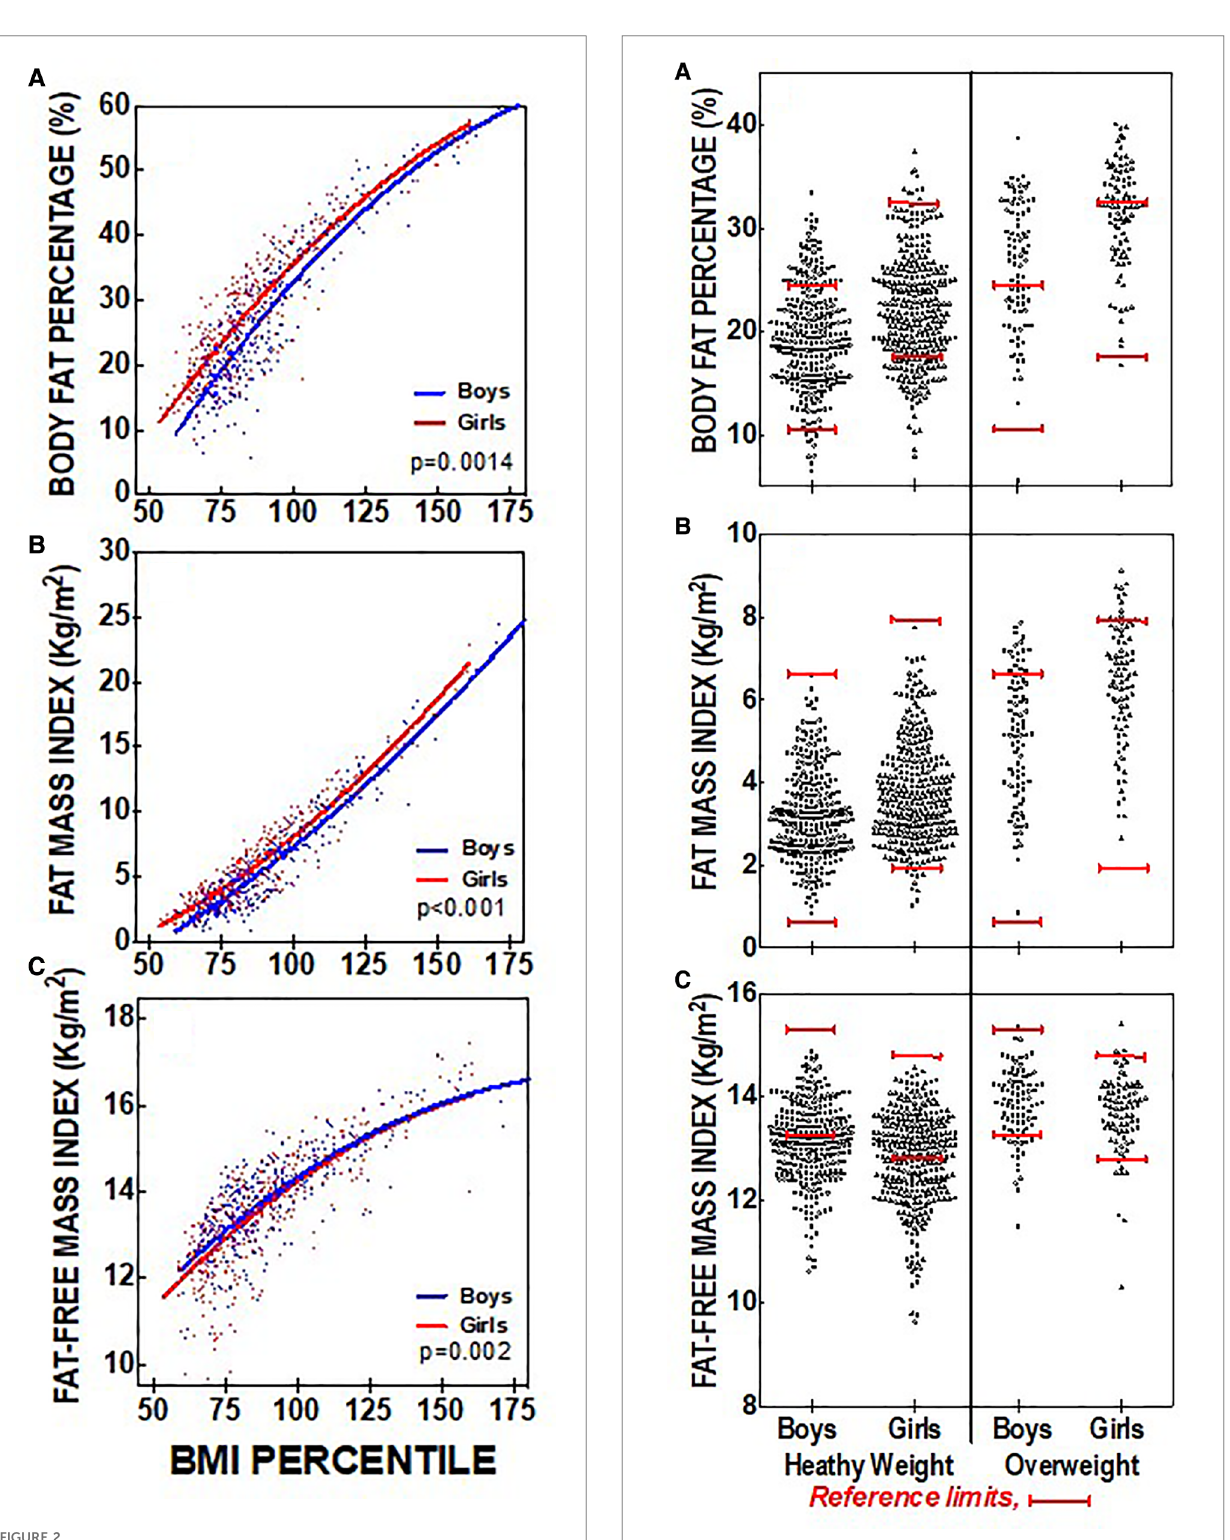
FIGURE 2 Distribution of body composition and indexes measures for the obese BMI%-based weight categories for boys and girls. ( A ) Solid red lines represent the referenced (27) optimal range body fat percentage for boys (>10% to <24%) and girls (>17% to <32%); ( B ) Solid red lines represent the referenced (28) mean±1SD for the Fat Mass Index for boys (3.5±3 kg/m 2 ) and girls (4.8±3 kg/m 2 ); ( C ) Solid red lines represent the referenced (28) mean±1SD for the Fat Free Mass Index for boys (14.2±1 kg/m 2 ) and girls (13.7±1 kg/m 2